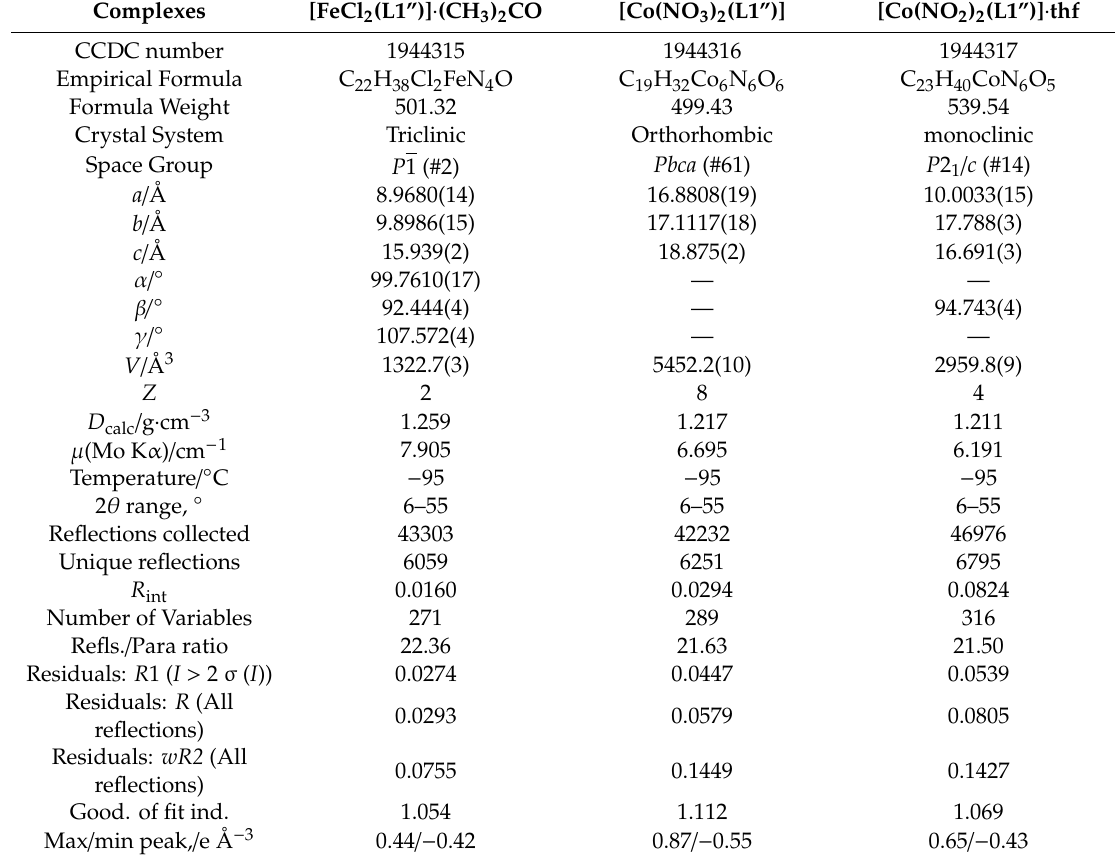
Table 4. Crystal data and structure refinement of the related